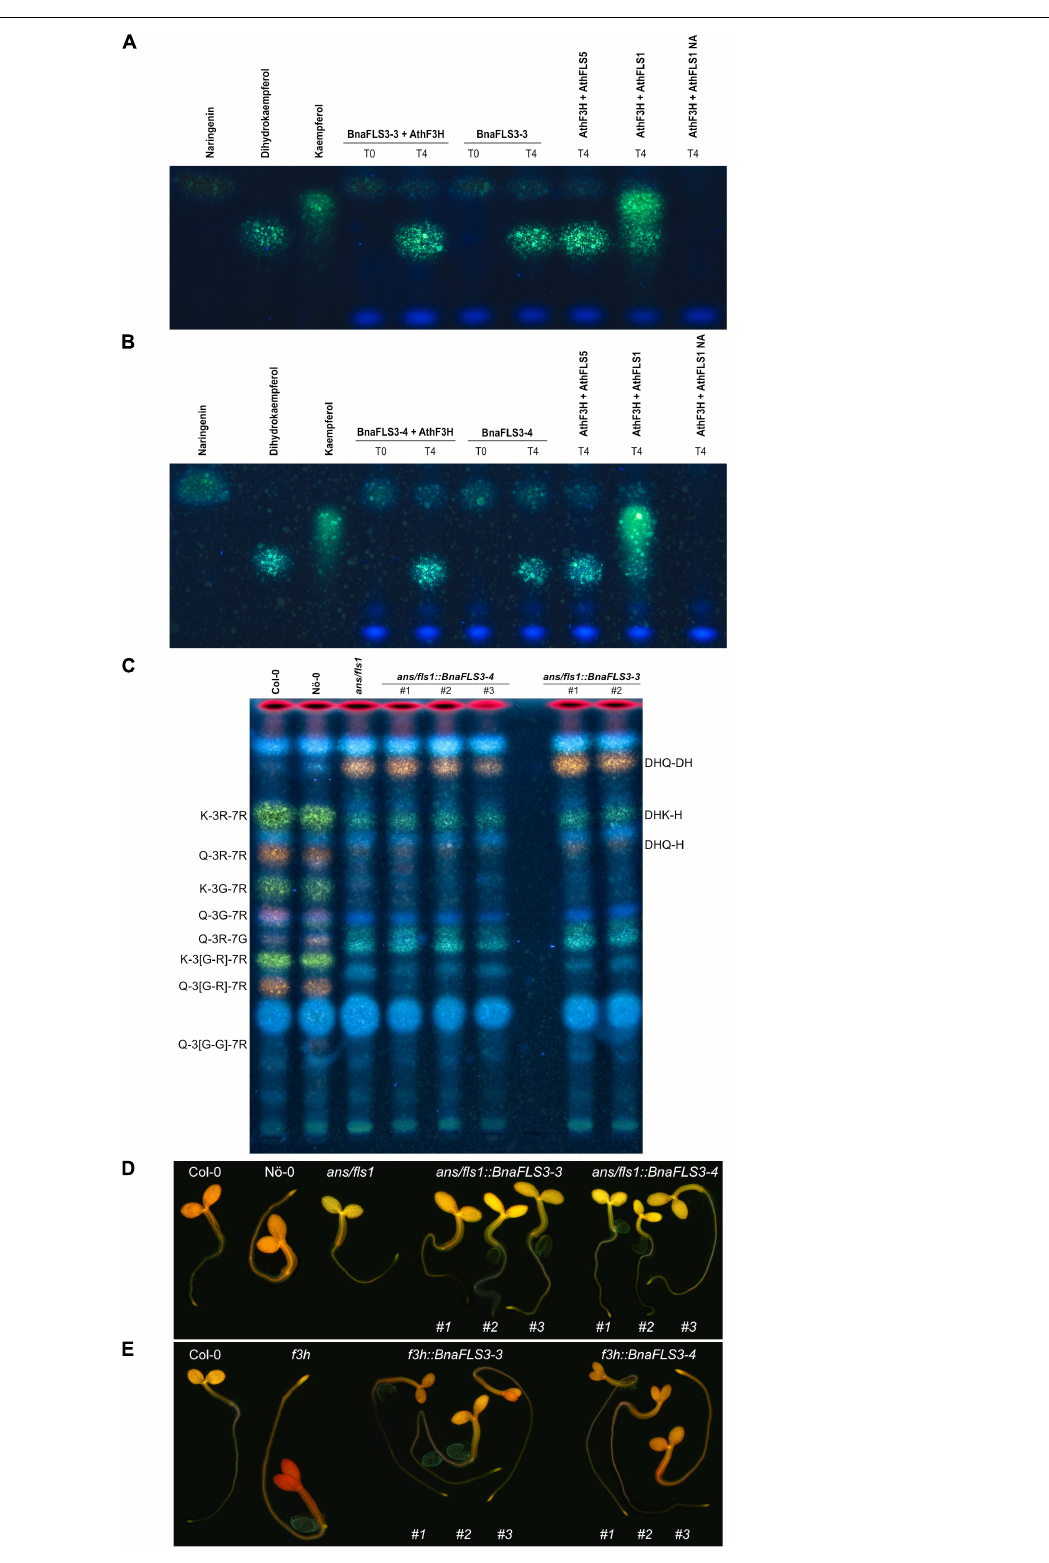
Frontiers in Plant Science |